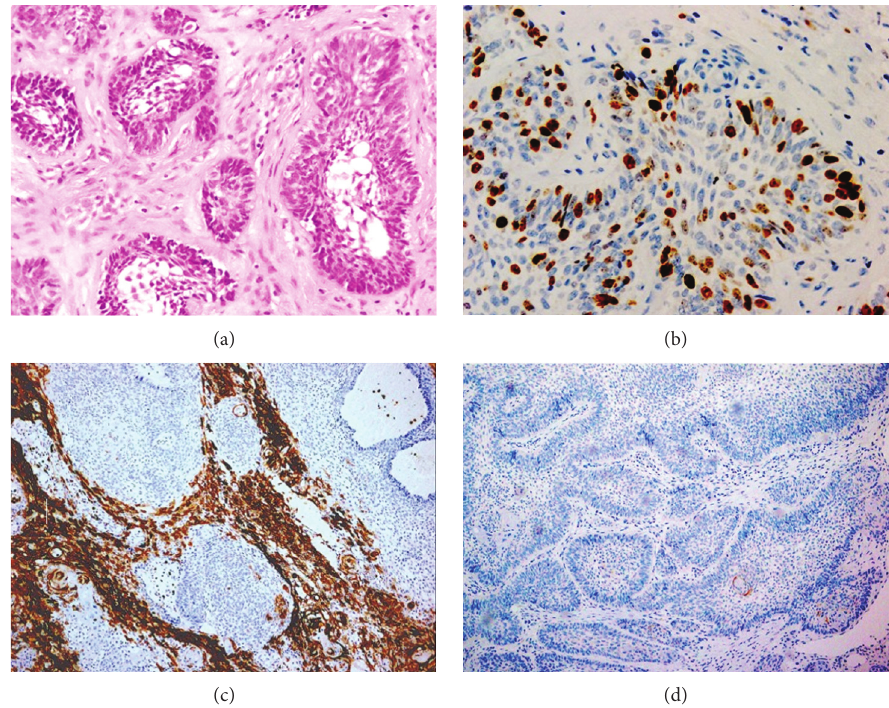
Figure 3: (a) Follicular epithelia with microcyst formation in the center (H&E staining, original magnification; 40 × ), (b) expression within nuclei of follicular epithelia (original magnification; 40 × ), (c) CD10 expression in stromal cells (original magnification; 10 × ), (d) Ber-EP4 negative expression (original magnification; 10 ×